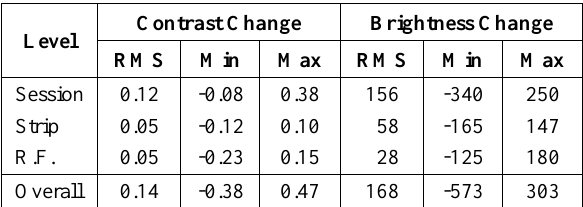
Table 2. Radiometric normalization parameters for the Nevada mosaic: RMS, minimum and maximum changes in contrast (factor) and brightness (DN offset) at different hierarchy levels (session, image strip and radiometry fixes within images).